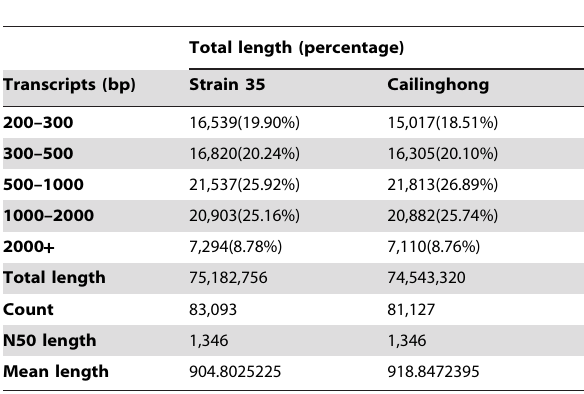
Table 2. Summary of transcripts for Sal via splendens